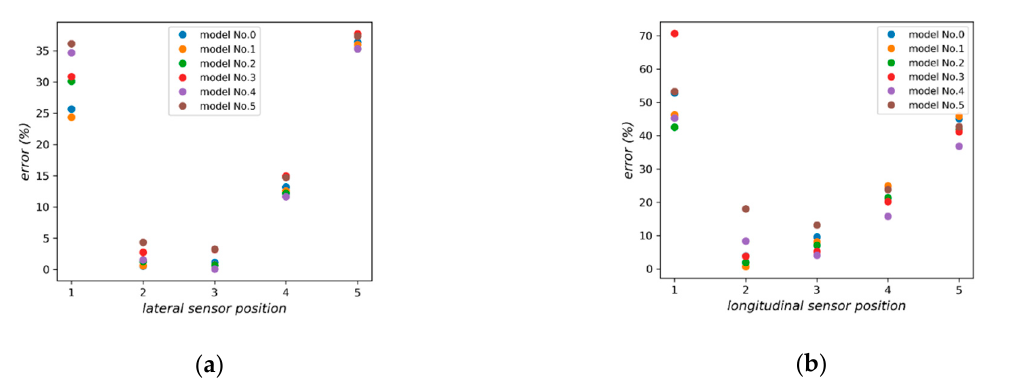
Figure 14. ( a ) Relative errors of lateral sensors in different depth, ( b ) Relative errors of longitudinal sensors in different depth.